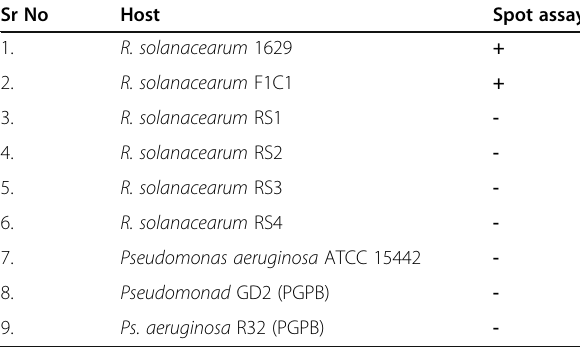
Table 2 Host range determination for phage ɸ sp1 on different Ralstonia solanacearum strains and plant growth-promoting bacteria (PGPB) Sr No Host Spot